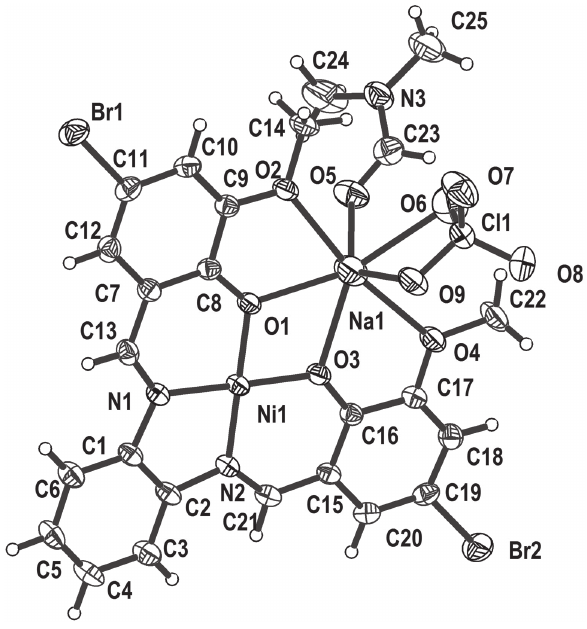
Table 1: Data collection and